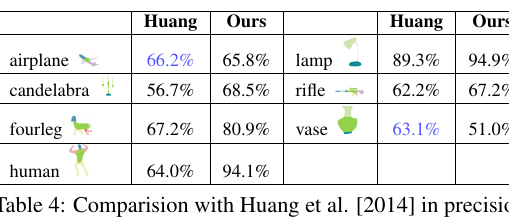
Figure 6: Representative results by our method and baseline solutions. The F1 measure is shown below each result.